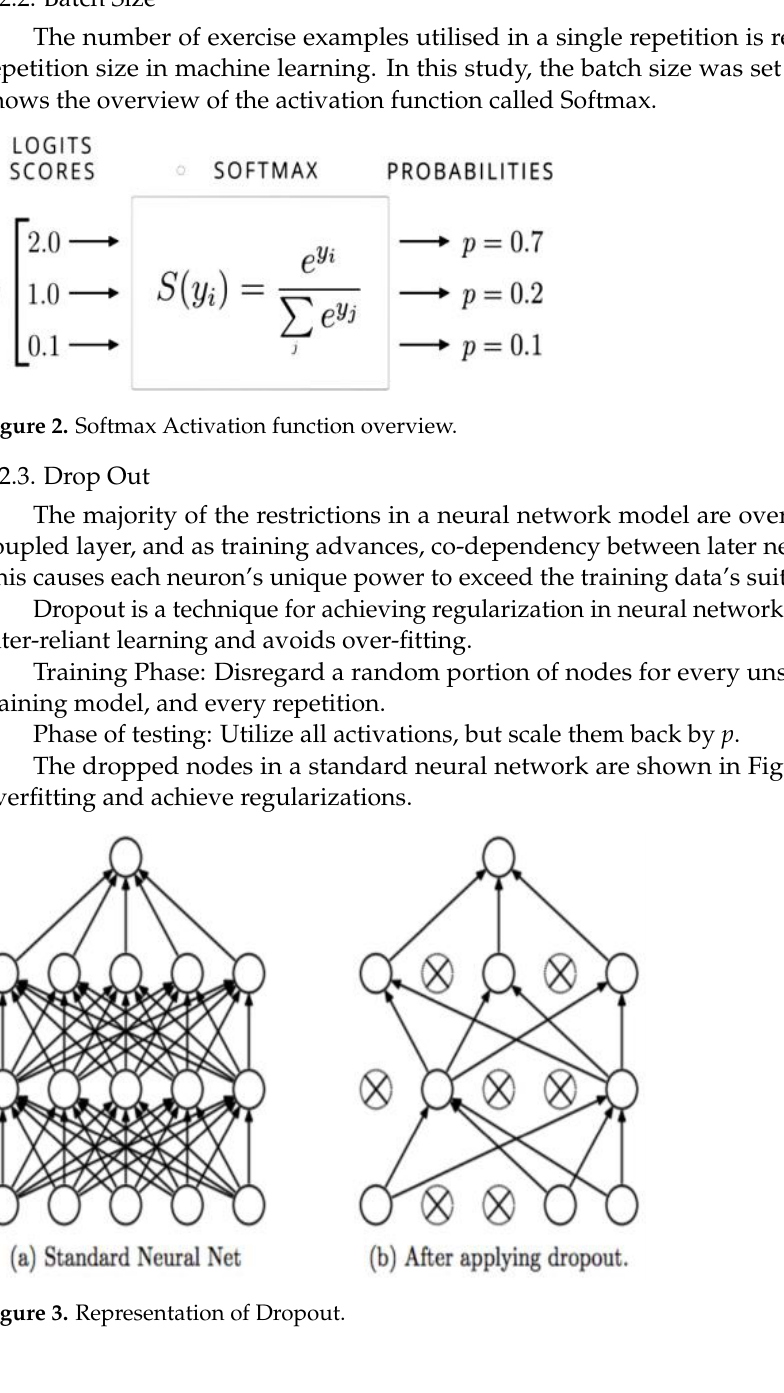
Figure 3. Representation of Dropout. With the exception of the output layer, which had a 0.4 drop-out, all layers had drop- outs set to 0.3. 2.2.4. Cross-Entropy It is a measurement of how different two probability distributions are from each other. The equation for Cross-Entropy can be found here: 𝐼 ( 𝑝, 𝑞 ) = − ∑ 𝑃 ( 𝑥 ) log 𝑞 ( 𝑥 )